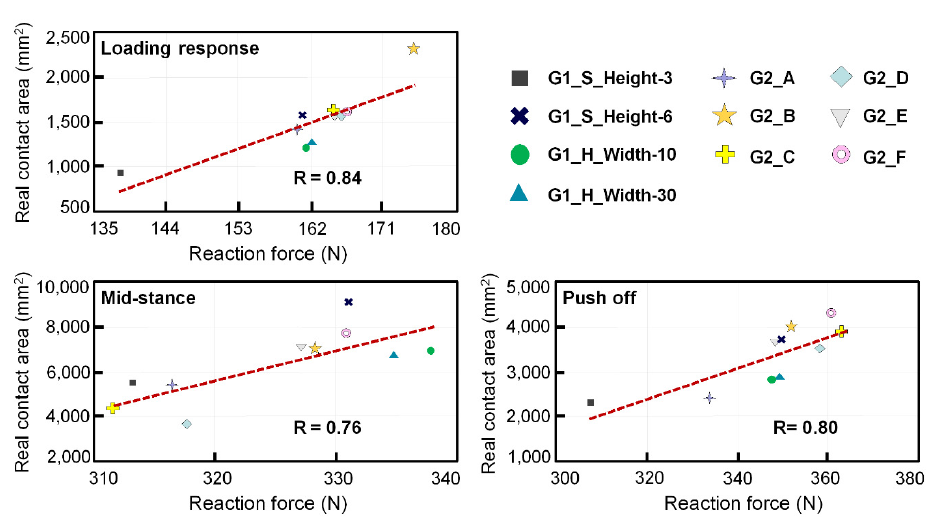
Figure 10. The relationship between ground reaction force and real contact area.